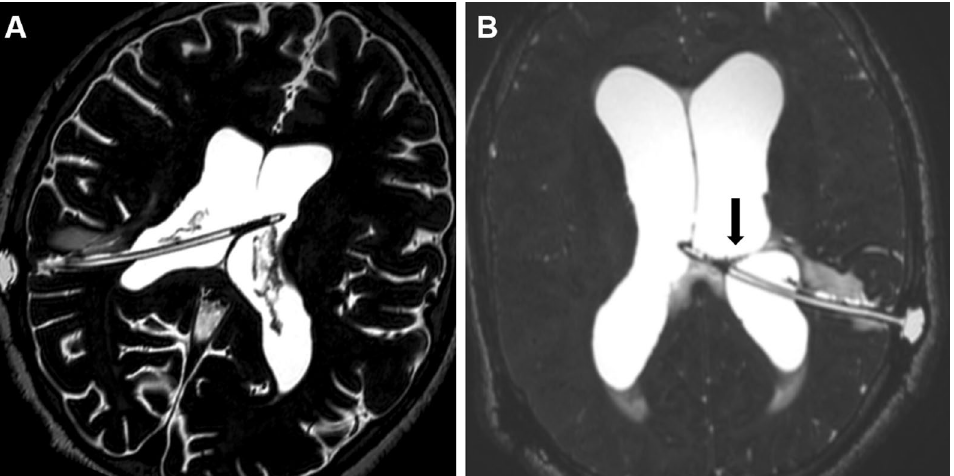
Fig. 7 Reconstructed 3D‑DRIVE in axial oblique planes. A A 15‑year‑old male patient presented with unsteady gait and convergent squint, B A 24‑year‑old male patient presented with headache and attacks of vomiting. Both show proximal catheter intraluminal dark signal occluding segment where side holes are located, closely adjacent to left lateral ventricular choroid plexus (could suggest choroid plexus ingrowth). In addition to transependymal permeation and adhesion between proximal catheter terminal part and related ventricular ependymal lining (arrow) in ( B